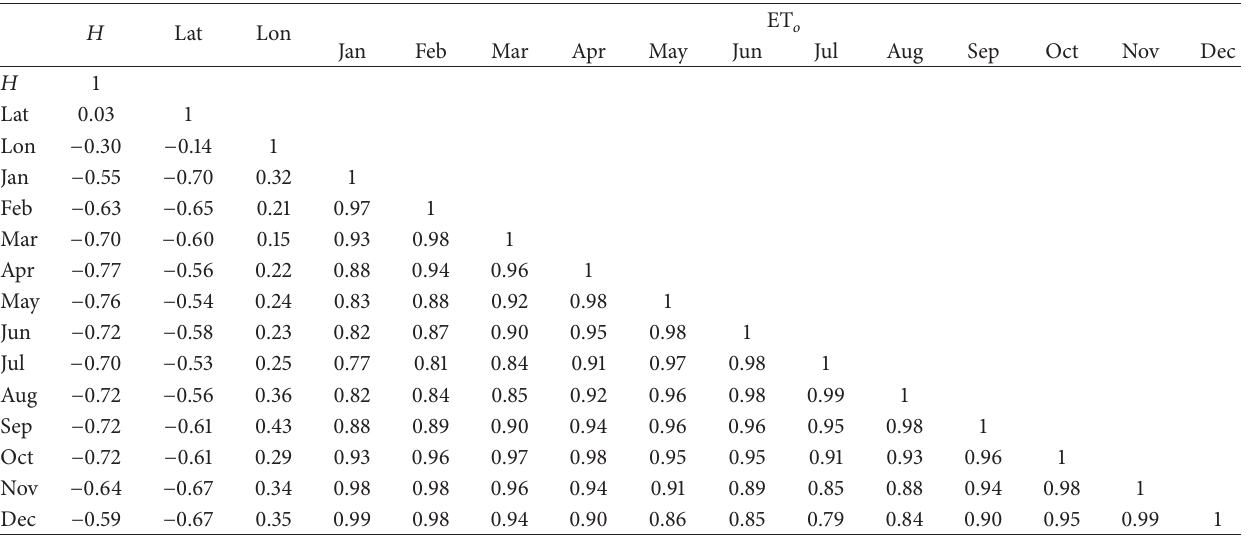
Table 1: Cross-correlation matrix of the mean monthly ET 𝑜 (January to December) as well as the latitude, longitude, and elevation images. Correlations are performed between pairs of variables taking values from pixels of the same geographical position.